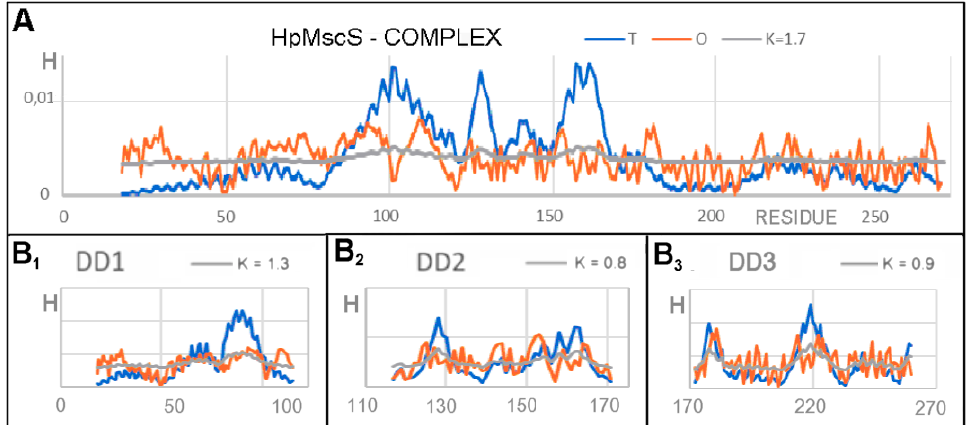
Figure 4. Set of T , O , and M profiles for determining the status of the A chain and domains in the complex, the 3DG function, and its modifications generated for the complex. ( A ) The status of the complex represented by chain A. The complete T, O, and M profiles for the complex are the profiles from Figure 4A replicated seven times. For clarity of the graphics, only chain A is shown. ( B ) Set of domains: ( B1 ) DD1, ( B2 ) DD2, ( B3 ) DD3; here also, a fragment duplicated seven times is shown rather than presenting the entire complex.